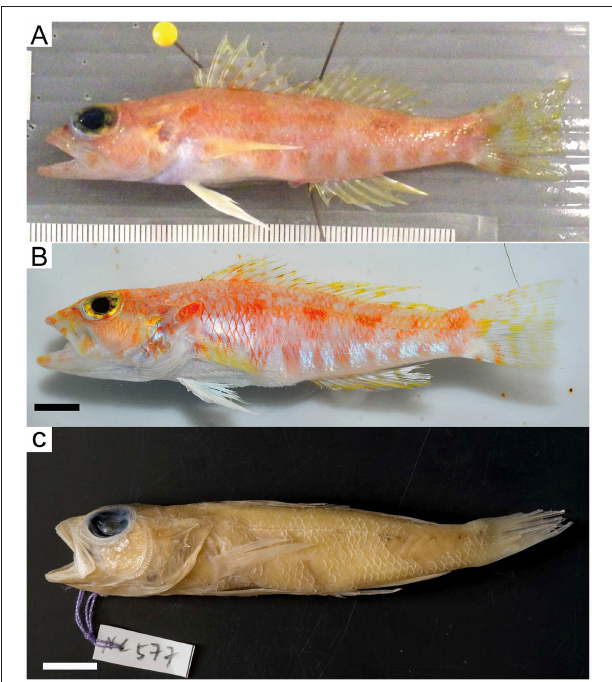
FIGURE 6 | Chelidoperca microdon sp. nov. from Chesterfield Island and Isle of Pines, Coral Sea. (A) MNHN 2019-0020 (NC577, holotype), Collected on 20 Aug 2016; standard length 79.5mm (photographed by WJC-Lab); (B) NTUM15636 (NC1451, paratype), Collected on 22 Sep 2017; standard length 93.5mm (photographed by MYL); (C) same specimen in (A) , showing preserved pigmentation (photographed by MYL). Bars = 10mm. FIGURE 7 | Chelidoperca barazeri nsp. from Gazelle Channel, Bismarck Sea